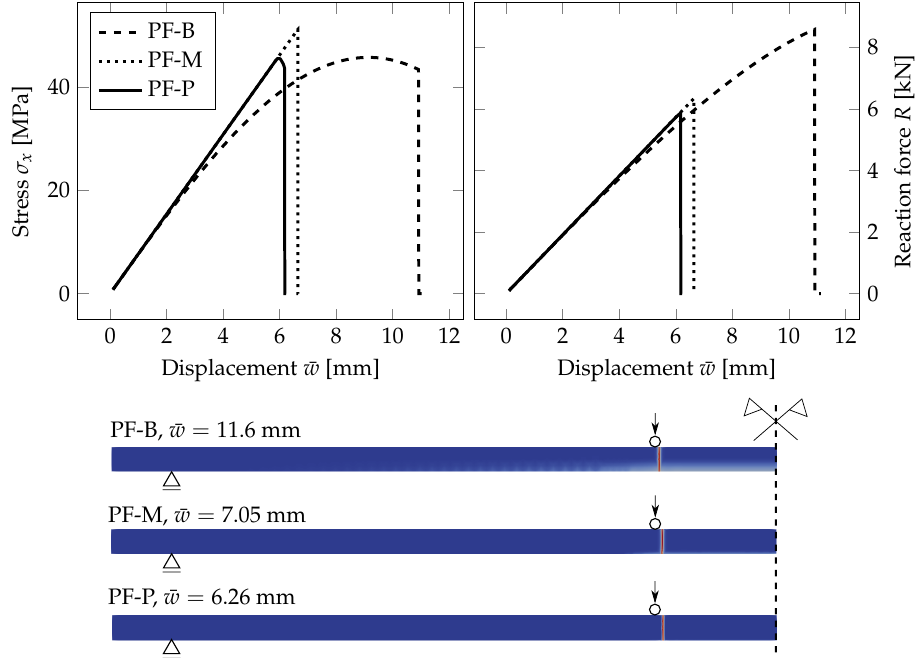
Figure 6. PS-Refined mesh, anisotropic staggered solver with the spectral-decomposition split: Comparison of phase-field formulations in terms of the evolution of the largest tensile stress at the midpoint and the overall reaction under the loading points for the prescribed displacement, complemented with the damage evolution plot showing the position of the localised cracks